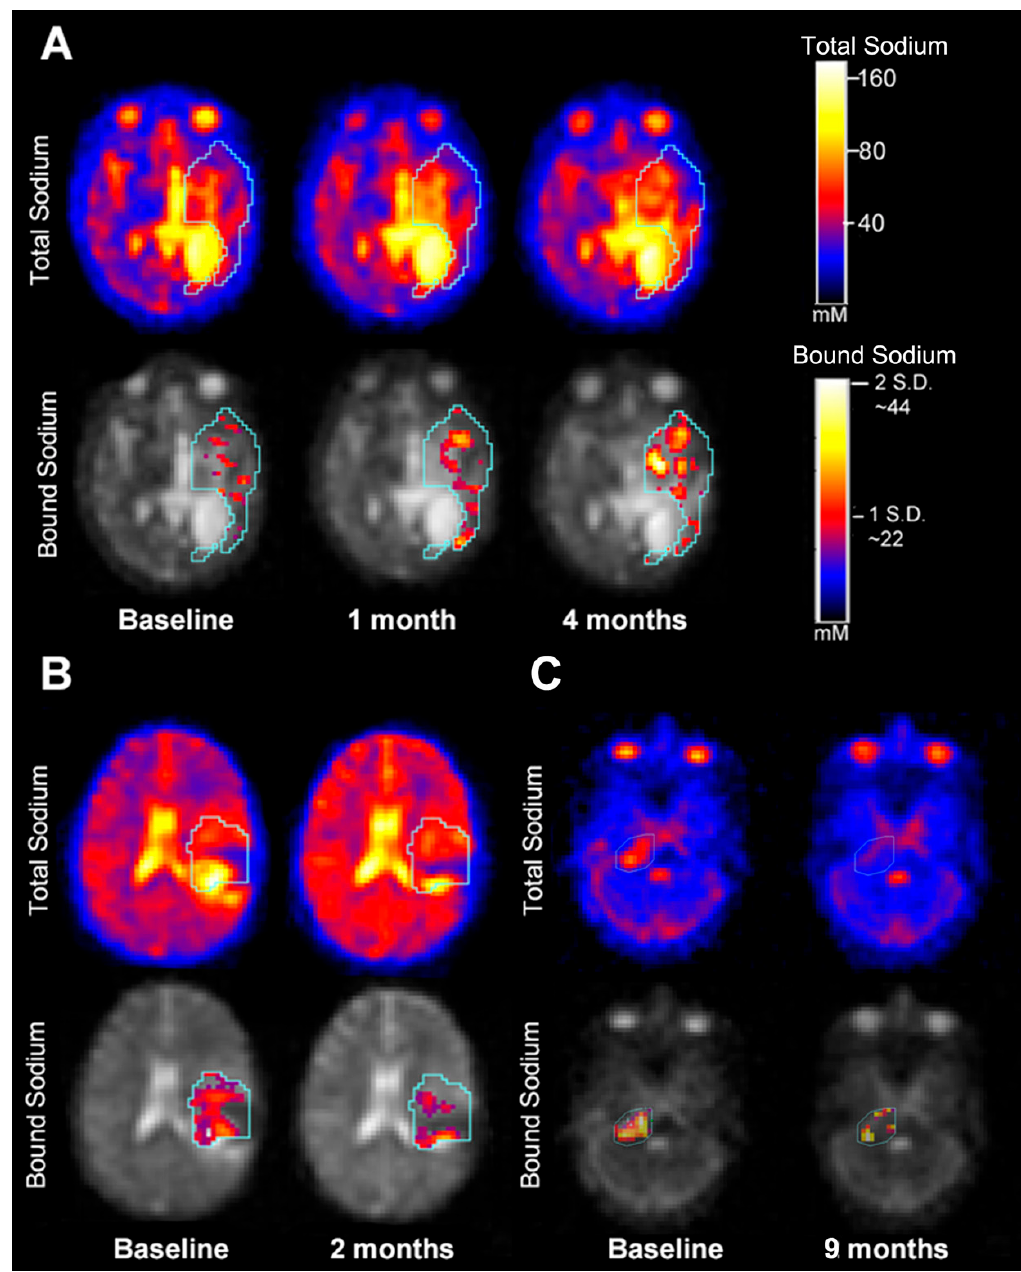
Figure 5. Two-TE sodium MRI scans showing tumor progression in high-grade glioma (Panel ( A ) [pt. ID 4027]), and response to therapy in supratentorial astrocytoma (Panel ( B ) [pt. ID 4010]) and in high-grade glioma (Panel ( C ) [pt. ID 4025). In the tumor regions of the bound sodium images are pixels of vBSC with a value greater than 1 standard deviation (S.D.) from the average vBSC value (~22 mM) over the tumor.